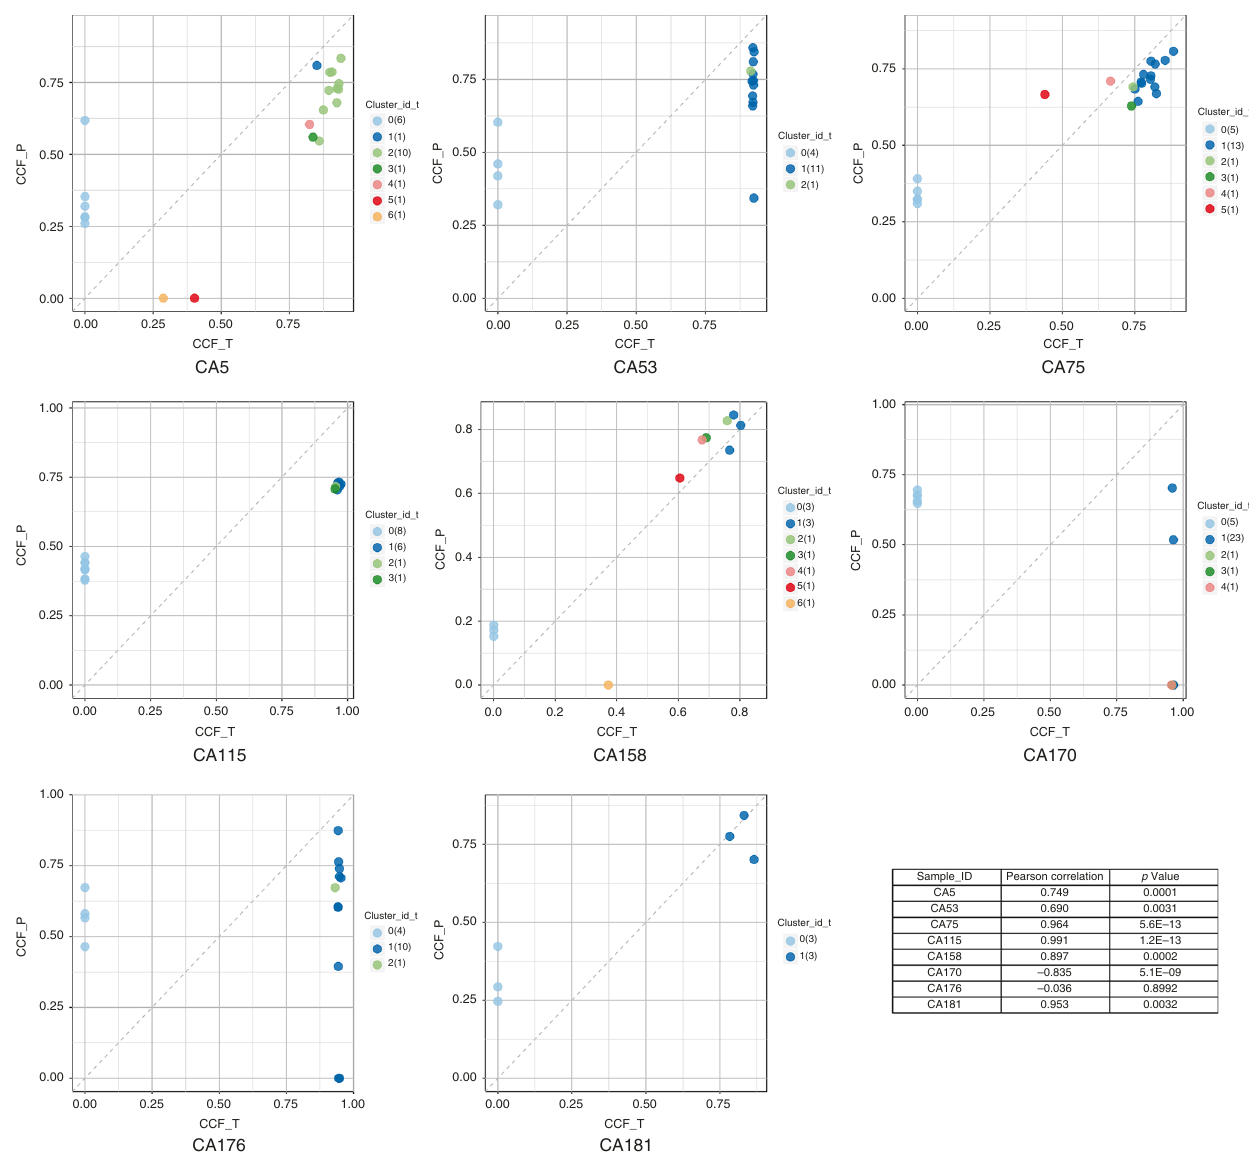
Fig. 3 Comparison of genomic architecture derived from paired ctDNA versus tumor DNA. CCF of mutations were calculated in ctDNA and tumor DNA. Each dot represents one mutation and the color of each dot indicates the subclone that given mutation was clustered to. Correlation of CCF of all mutations in each pair of samples was shown in the table at lower-right corner. CCF_P: CCF of mutations in ctDNA; CCF_T: CCF of mutations in tumor